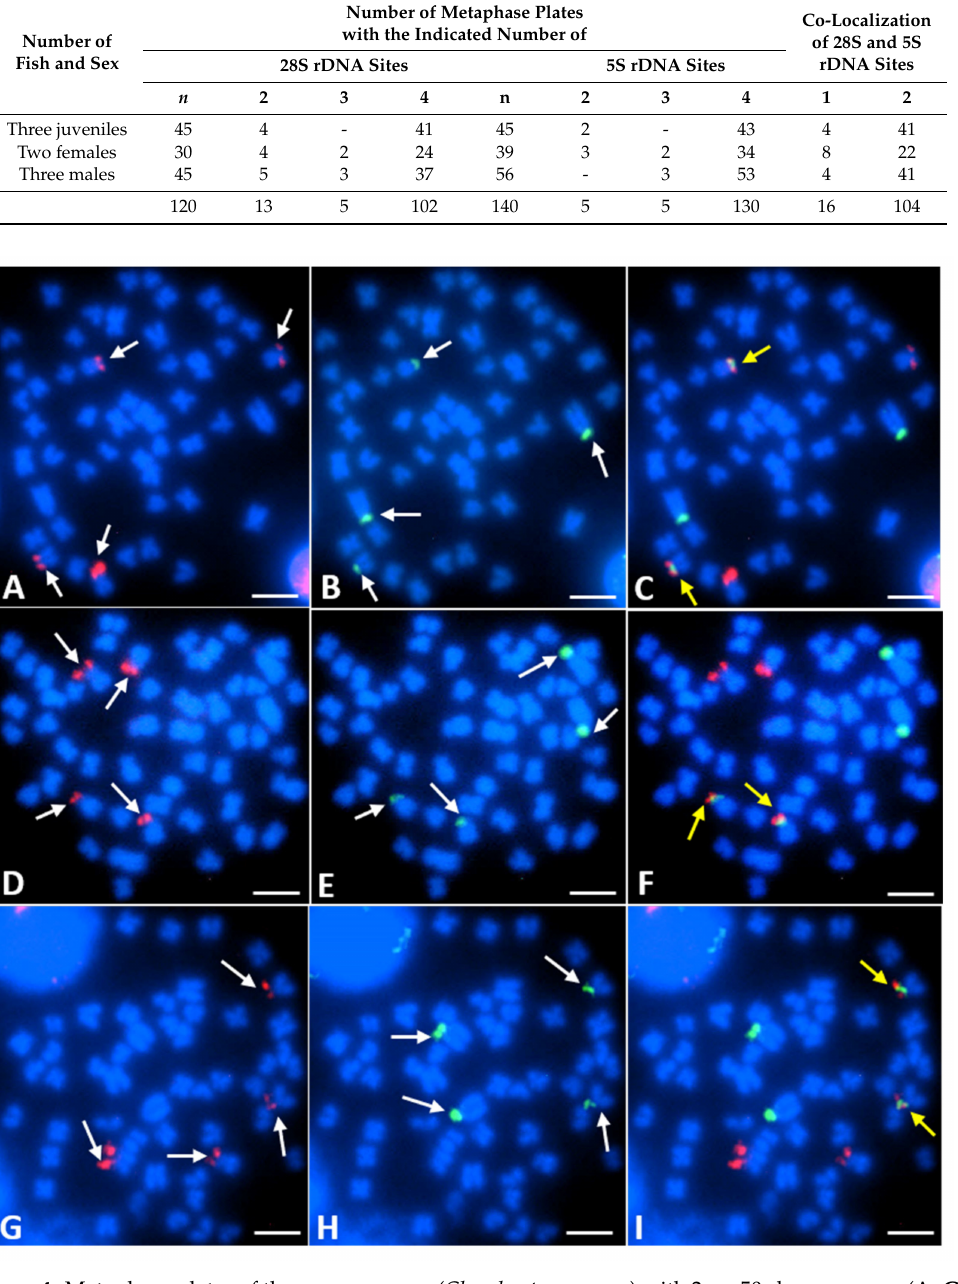
Figure 4. Metaphase plates of the common nase ( Chondrostoma nasus ) with 2n = 50 chromosomes ( A – C ); 2 n = 51 chromosomes ( D – F ); and 2 n = 52 chromosomes ( G – I ) after fluorescence in situ hybridization (FISH) analysis with 28S rDNA as a probe ( A , D , G ); 5S rDNA ( B , E , H ); and both of these sequences ( C , F , I ). 28S rDNA (red signals) and 5S rDNA (green signals) hybridization sites are shown by white arrows, whereas co-localizations of both these sequences are indicated by yellow arrows. (Bar = 10 µ